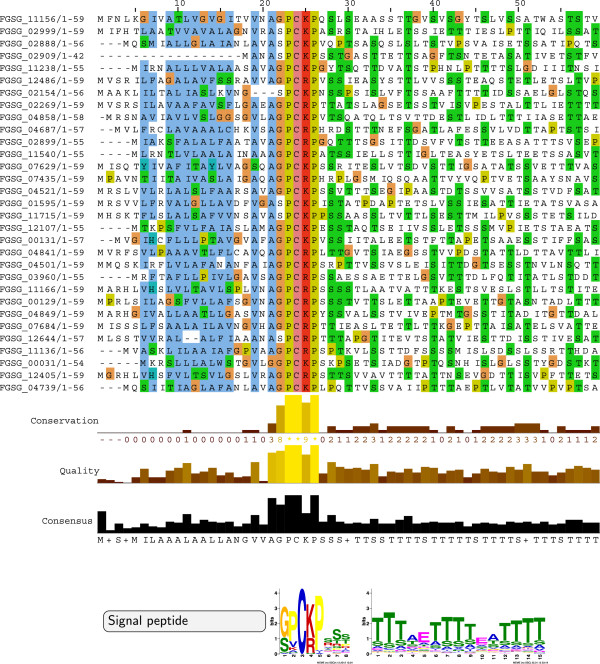
A highly conserved N-terminal [SG]-P-C-[KR]-P motif in a subset of F. graminearum proteins. MEME returns a [SG]-P-C-[KR]-P motif (e-value 3.4e-091) adjacent to the predicted signal peptide cleavage site for 37 of the 110 proteins in cluster C8. A MUSCLE alignment of the N-terminal region of a core set of well-aligned 31 of those proteins is visualized by Jalview. The MEME logos are shown with the [SG]-P-C-[KR]-P motif followed by a serine-/threonine-rich stretch. An iterative public database search of these aligned sequences (jackhmmer) returned additional members of this putative protein family in F. graminearum, F. pseudograminearum, F. oxysporum and F. solani.